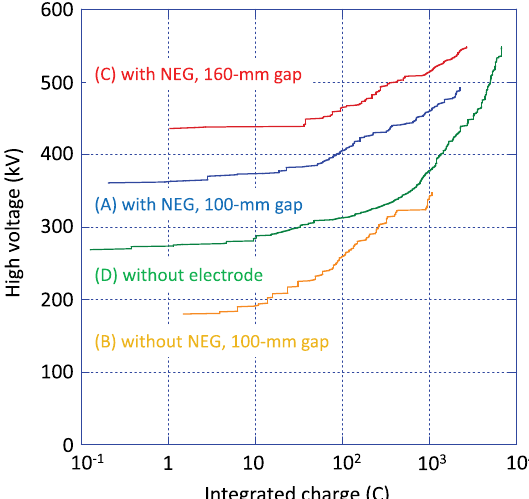
6. High voltage as a function of integrated charge released during HV conditioning. The blue solid line labeled (A) was obtained with acceleration gap d ¼ 100 mm with NEG pumps placed around the gap. The orange solid line (B) was obtained with d ¼ 100 mm without NEG pumps. The red solid line (C) was obtained with d ¼ 160 mm with NEG pumps. The green solid line (D) was obtained without a cathode